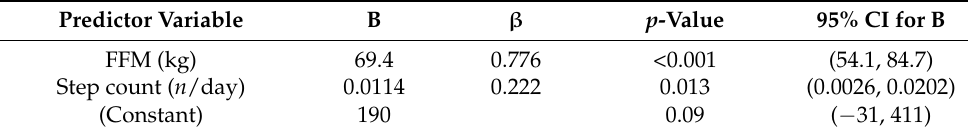
Table 3. Regression analysis for predicting TEE (kcal/day).